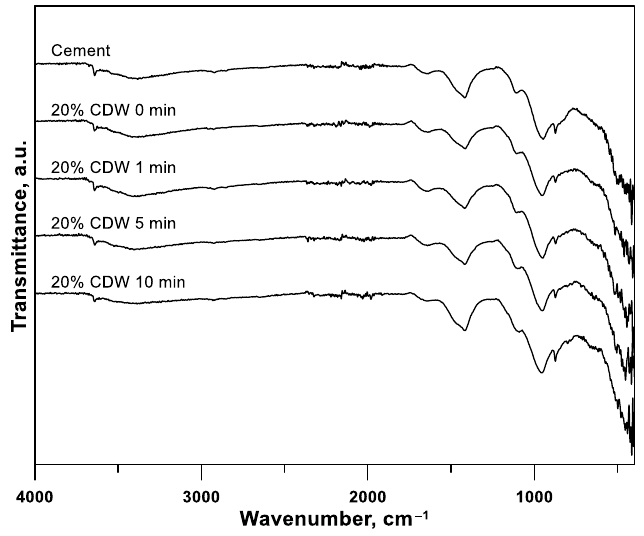
Figure 5. The FT-IR spectra of specimens (cement replacement with 20% CDW).